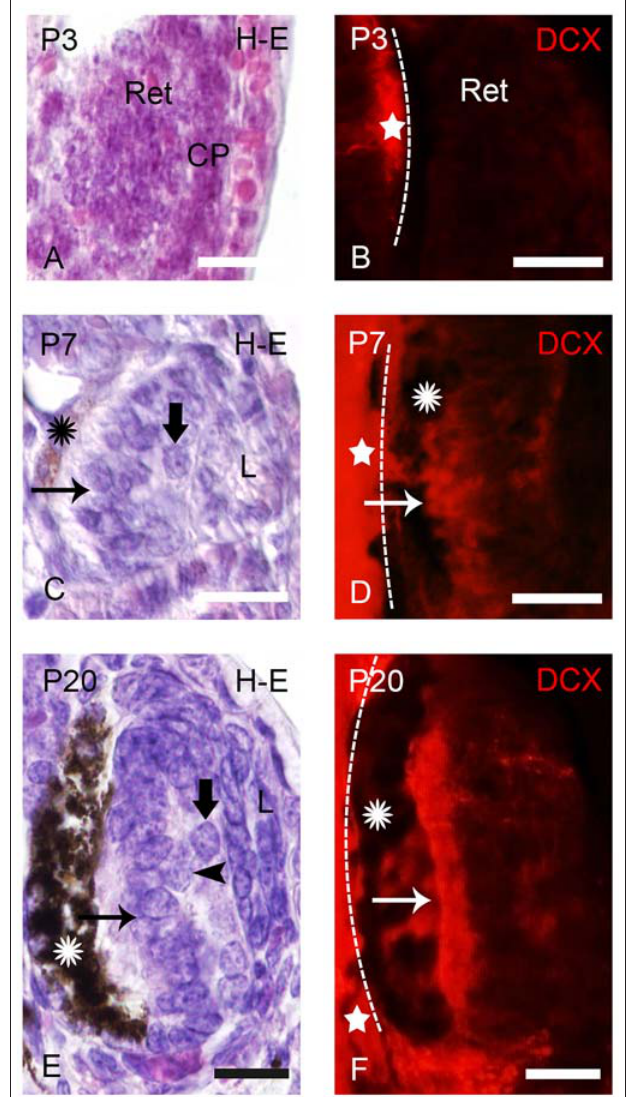
FIGURE 1 | Photomicrographs of transverse sections of retina in prolarval sea lampreys showing hematoxylin-eosine (H-E) labeling (A,C,E) or doublecortin (DCX) immunoreactivity (B,D,F). The H-E and DCX panels are from different animals, but at similar levels. In the DCX panels the dashed lines indicate the limit between the retina and the brain (the brain is always to the left). (A) Retina of a pigmentation prolarva (a p3) showing the early retina (Ret), which is formed by undifferentiated cells. Note the presence of the crystalline placode at this developmental stage (CP). (B) Photomicrograph of the retina of a p3 prolarva showing the absence of DCX immunoreactivity. Note DCX immunoreactivity in the brain (star) in the same section. (C) Retina of a gill cleft prolarva (p7) showing the primordium of the lens (L), ganglion cells (thick arrow), photoreceptors (arrow) and the retinal pigment epithelium with melanin granules (asterisk). (D) DCX immunoreactivity in cells of the outer (photoreceptors) and inner layers of the retina of a p7 prolarva. (E) Retina of a burrowing prolarva (p20) showing ganglion cells (thick arrow), bipolar cells (arrowheads) and photoreceptors (arrow). The retinal pigment epithelium contains abundant melanin granules. (F) Retina of a p20 prolarva showing DCX immunoreactivity in perikarya and outer segments of photoreceptors and in a few cells and fibers of the inner region. In all photomicrographs dorsal is up and medial is to the left. Scale bars: 25 µ